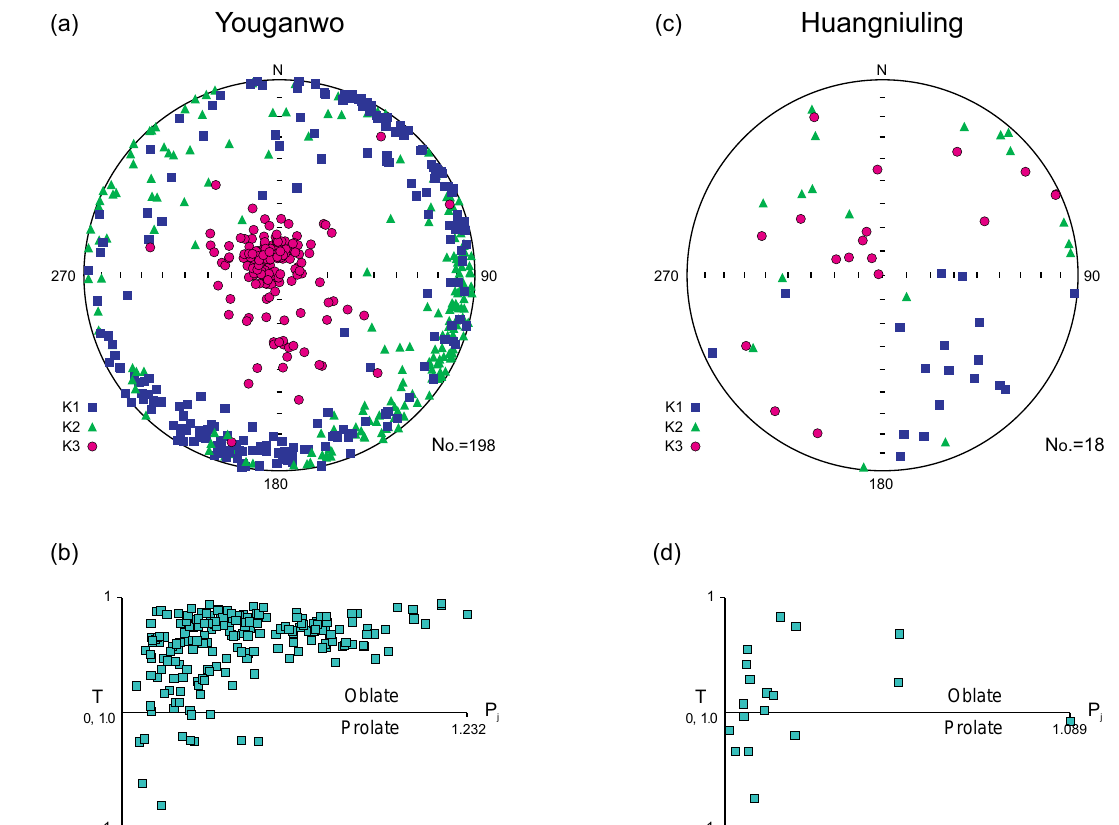
Figure 4. Anisotropy of magnetic susceptibility (AMS) data of the Youganwo Fm (a, b) and the Huangniuling Fm (c, d) . k 1, k 2, and k 3 are the maximum, intermediate, and minimum axis of the anisotropy ellipsoid, respectively. Panels ( a, c ) show the equal area projection of these principal axes. “No.” indicates the number of specimens. T and Pj in (b, d) are the shape factor and the degree of anisotropy, respectively (Jelinek,